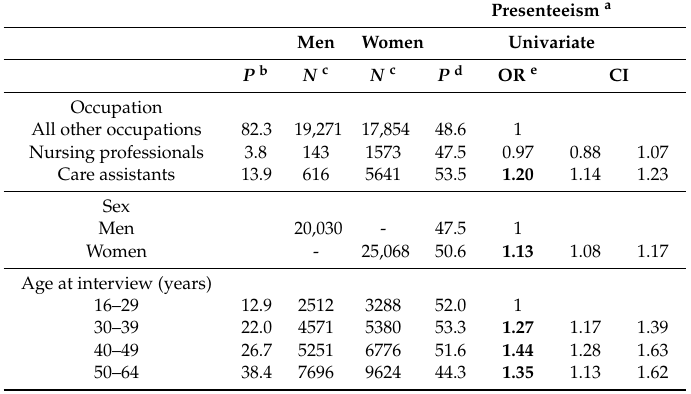
Table 1. Number of individuals, prevalence, and odds ratios (ORs) of presenteeism (two times or more) with 95% confidence intervals (CIs), related to sociodemographic variables (sex, age, education) , employment sector, country of birth, occupation, and work ability, interviewed 2001–2013 a